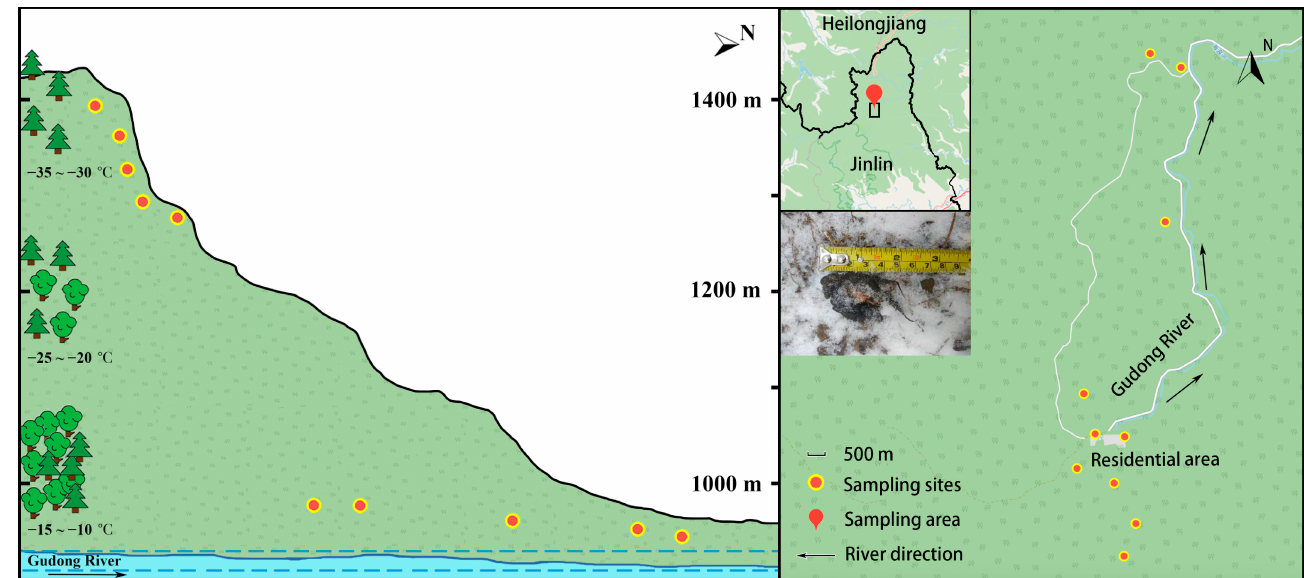
Figure 1. Distribution map and vertical section of sampling sites in Xuexiang National Park in north Jilin, China. Temperature indicates the field temperature range at 1000 m, 1200 m, and 1400 m at night, respectively. Red-Yellow symbol in the right panel indicate approximate altitude of each sampling site within 500 m range.